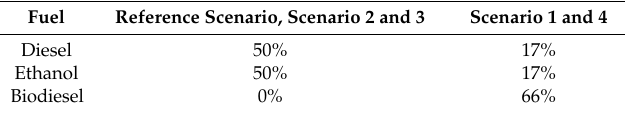
Table A7. Average fuel mix for buses for the different scenarios.